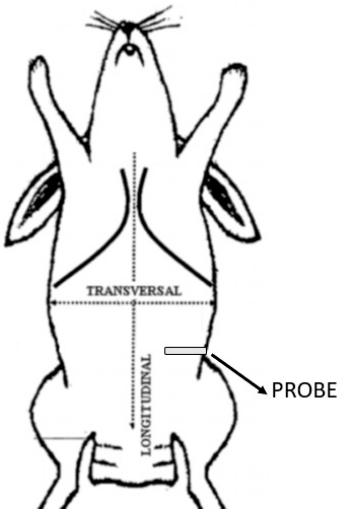
Figure 1. Schematic representation of the reference point corresponding to the intermediate point between the last rib and the iliac crest. the probe is positioned perpendicular to the column.